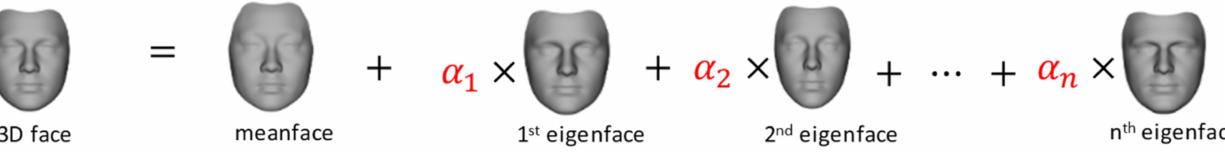
Figure 3. Patient-specific 3D face model was reconstructed using mean face, eigenfaces, and